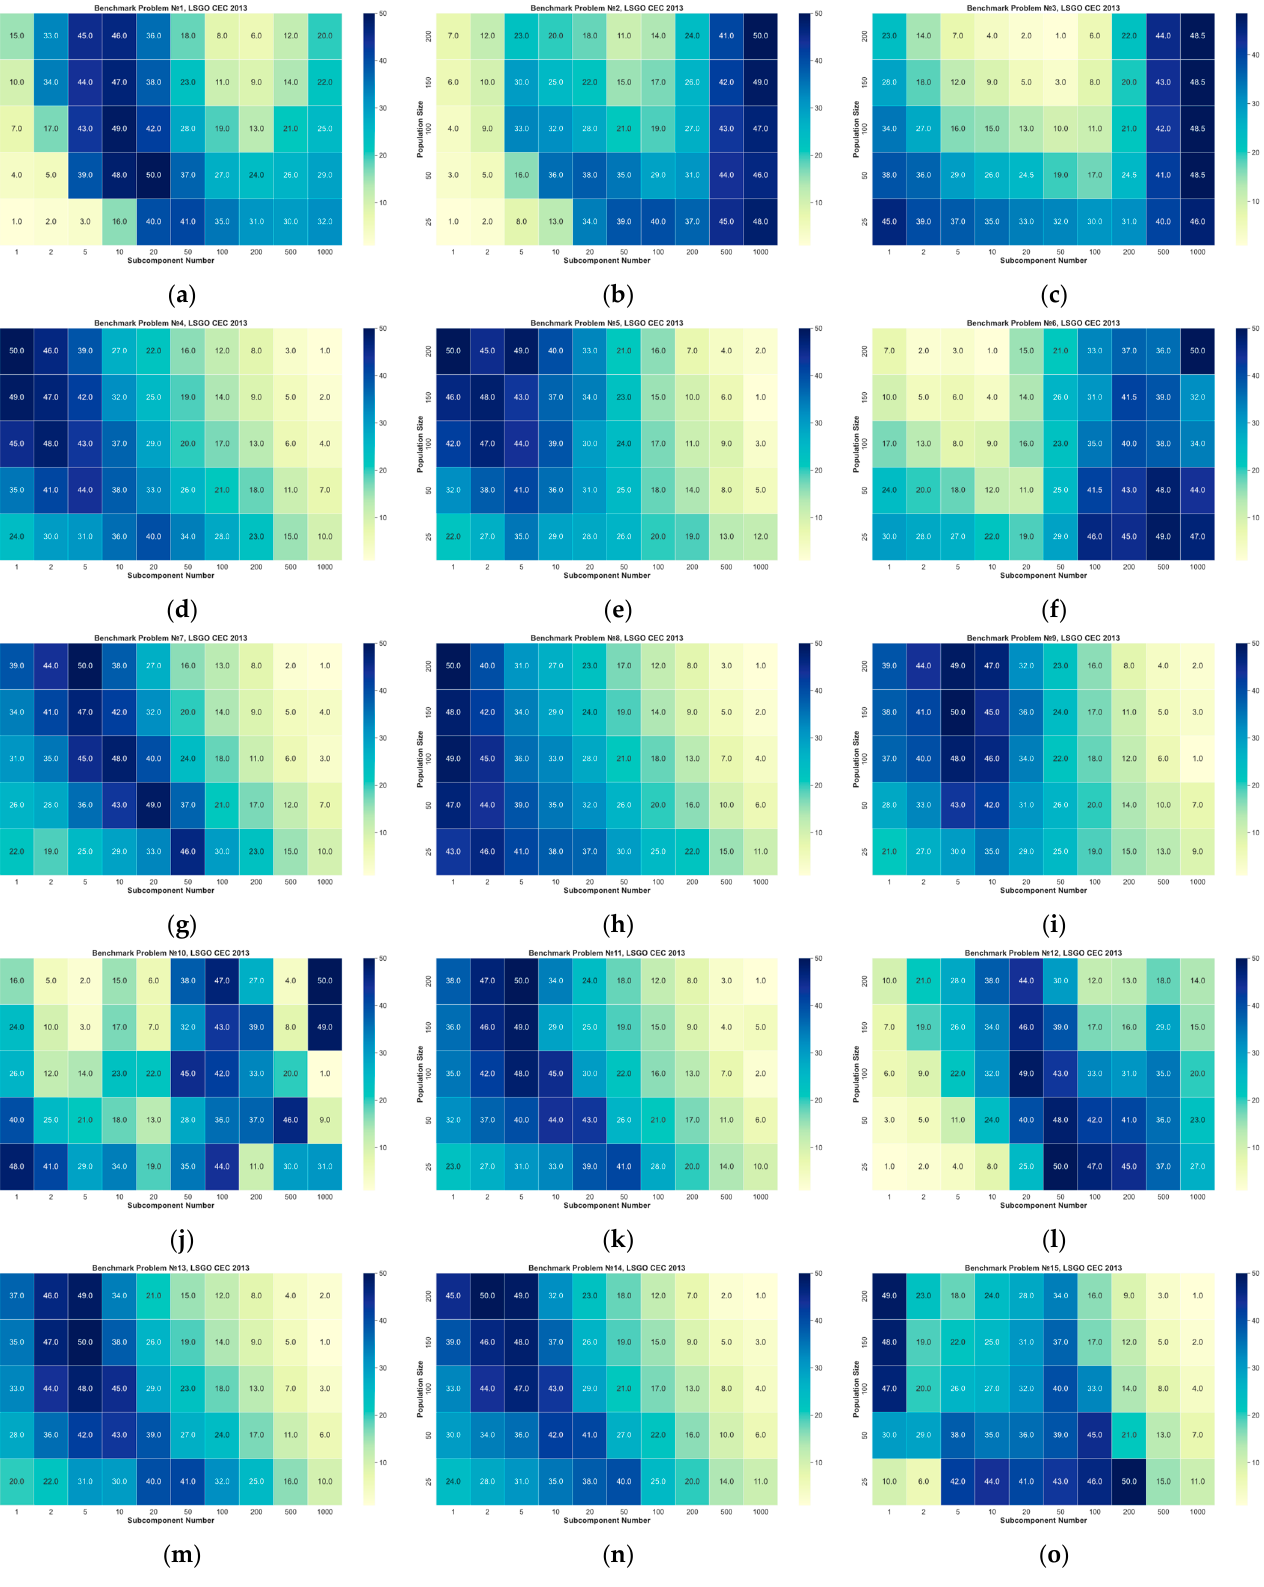
Figure 1. Ranking CC-SHADE algorithms with the static population size and the number of sub- components. Benchmark problems are: ( a ) F 1 ; ( b ) F 2 ; ( c ) F 3 ; ( d ) F 4 ; ( e ) F 5 ; ( f ) F 6 ; ( g ) F 7 ; ( h ) F 8 , ( i ) F 9 ; ( j ) F 10 ; ( k ) F 11 ; ( l ) F 12 ; ( m ) F 13 ; ( n ) F 14 ; ( o ) F 15 .